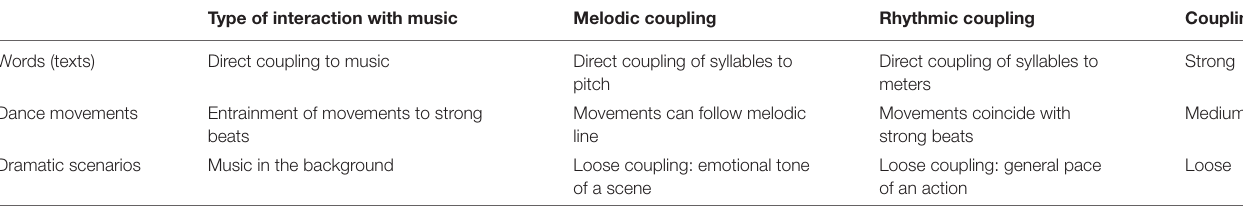
TABLE 1 | Strength of coupling between artforms during “musical